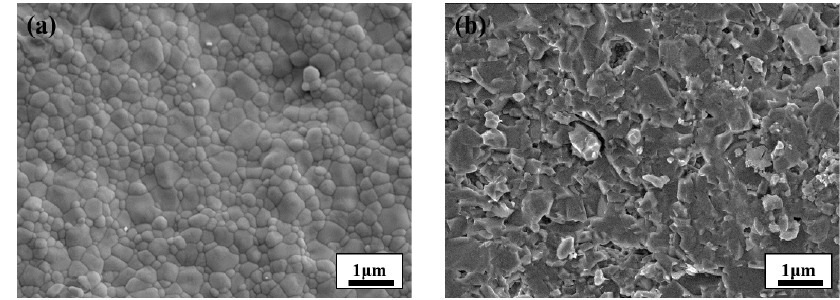
Figure 1. SEM electronic scanning images: ( a ) ZrO 2 Ceramics; ( b ) Al 2 O 3 Ceramics.